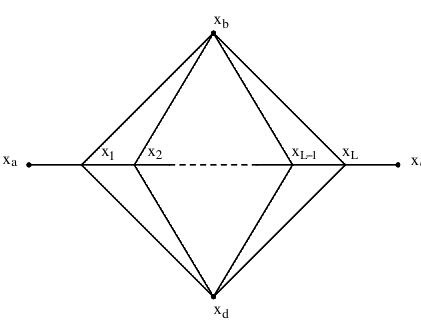
Figure 10. Diagrammatic representation of the integral D L